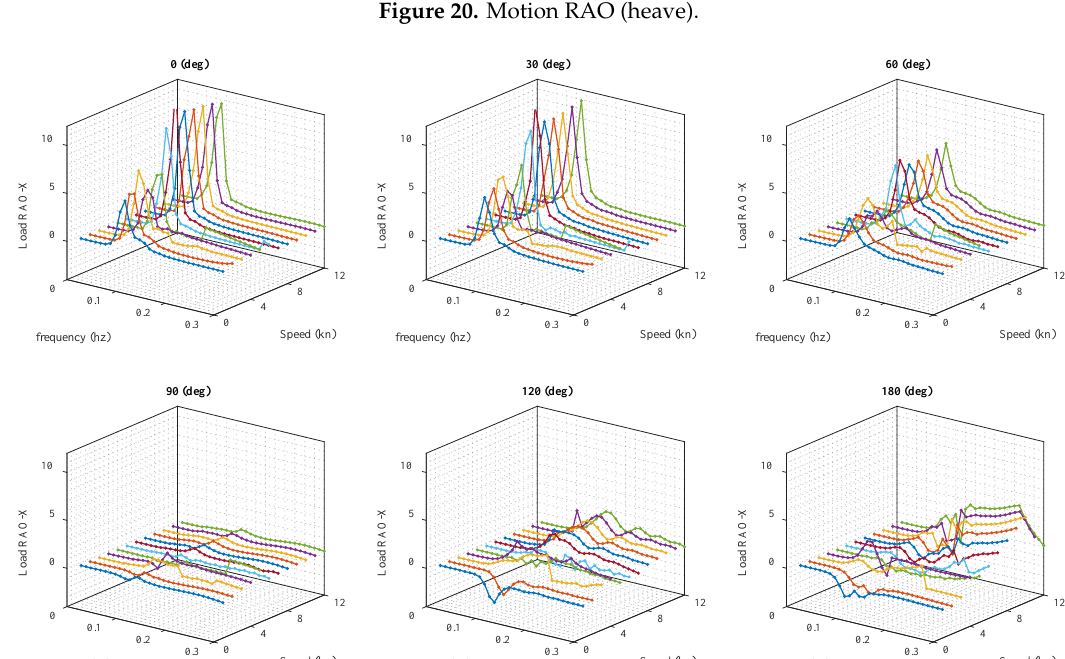
Figure 21. Wave load RAO (X-direction, second-order).